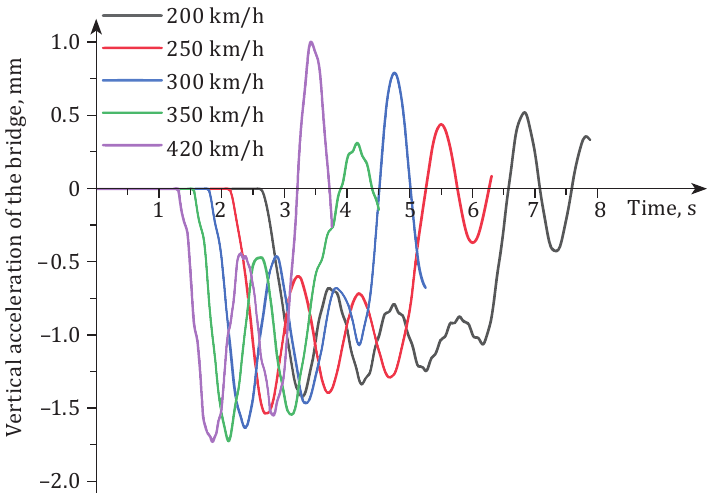
Figure 19. Comparison of vertical displacement time history at bridge